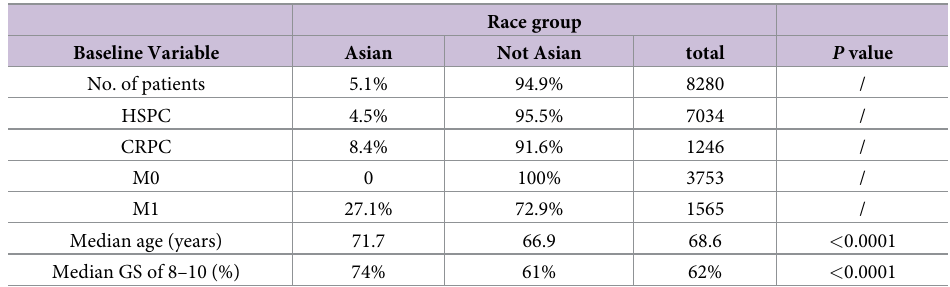
Table 2. Baseline of